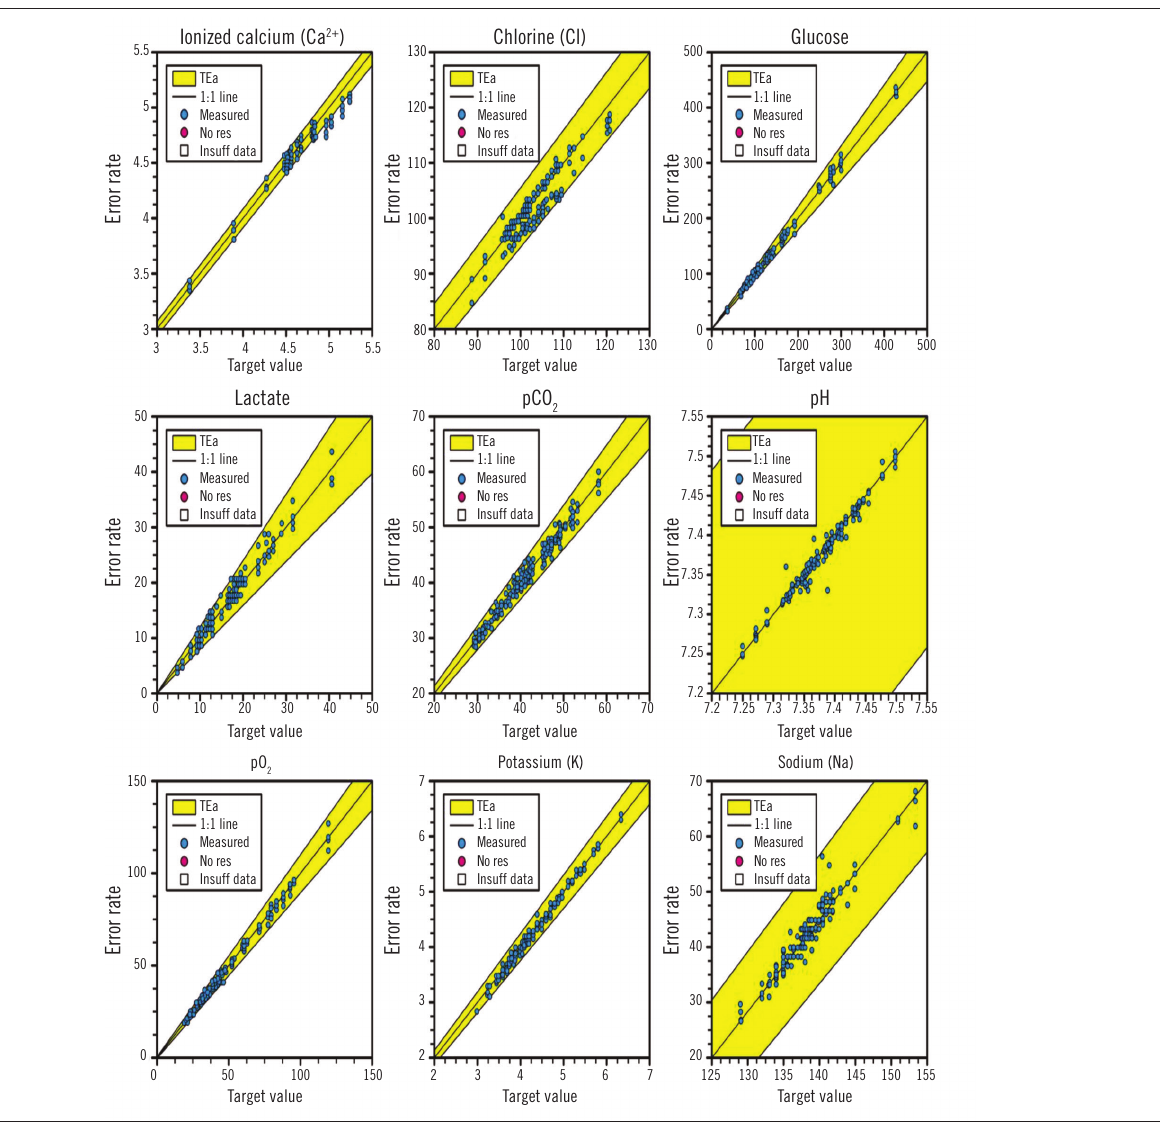
figuRE 1 − Analysis of linear regression of parameters TEa: total error